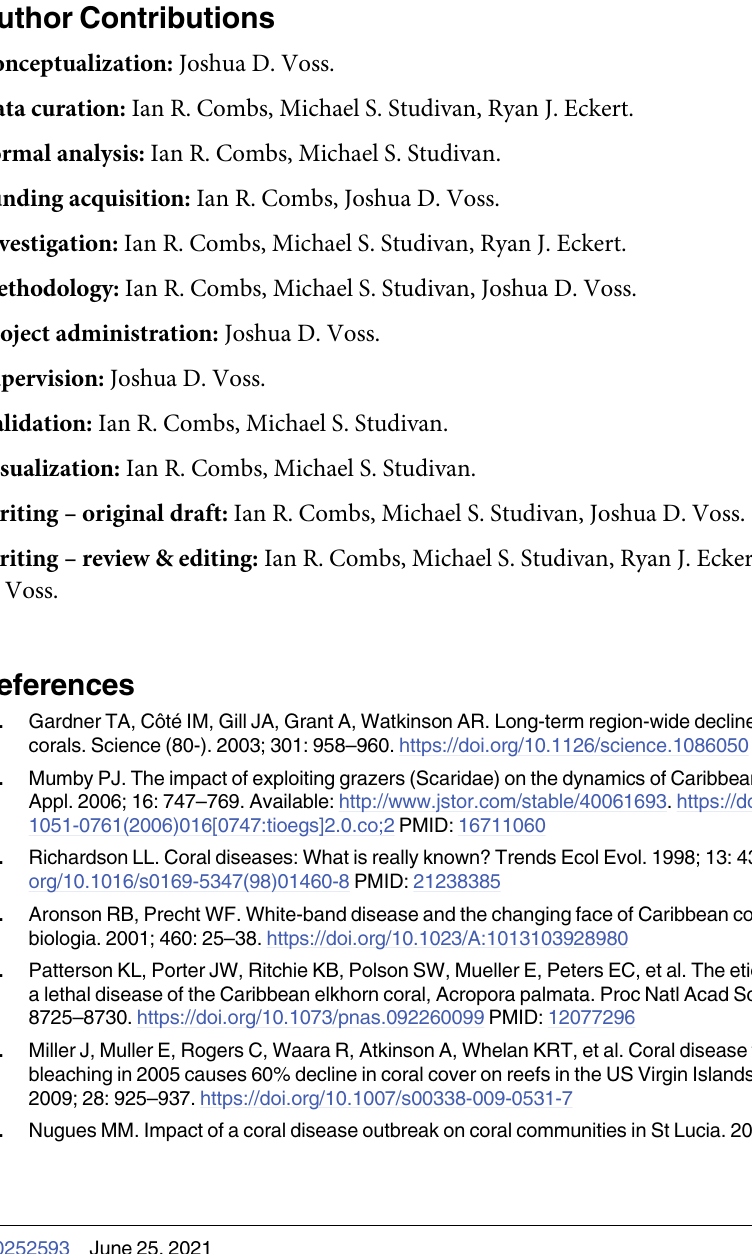
S3 Dataset. Dataset containing shape surface area and error measurements from prism deployment across three sites (pool, Lauderdale-by-the-Sea, St. Lucie Reef). Error was cal- culated as the absolute difference between measured surface areas and actual area of the tem- plate shapes, then standardized as a percentage relative to template area.